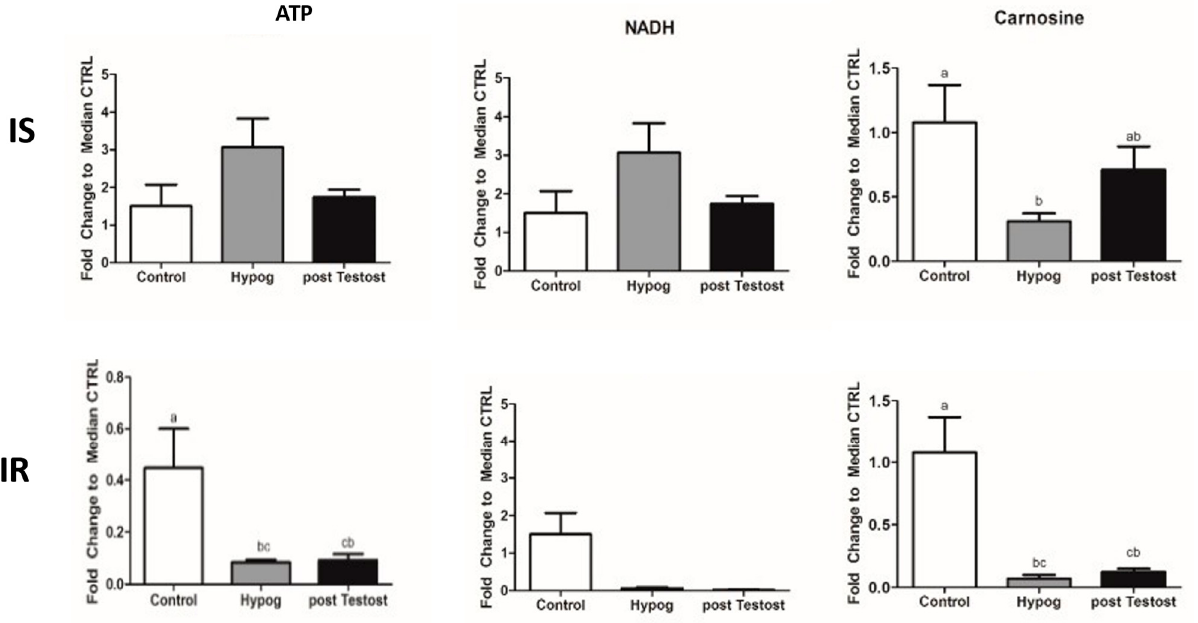
Figure 3. ATP, NADH and carnosine changes in control and hypogonadism subjects, before and after TRT. The data shown are from previous published papers [53,54].